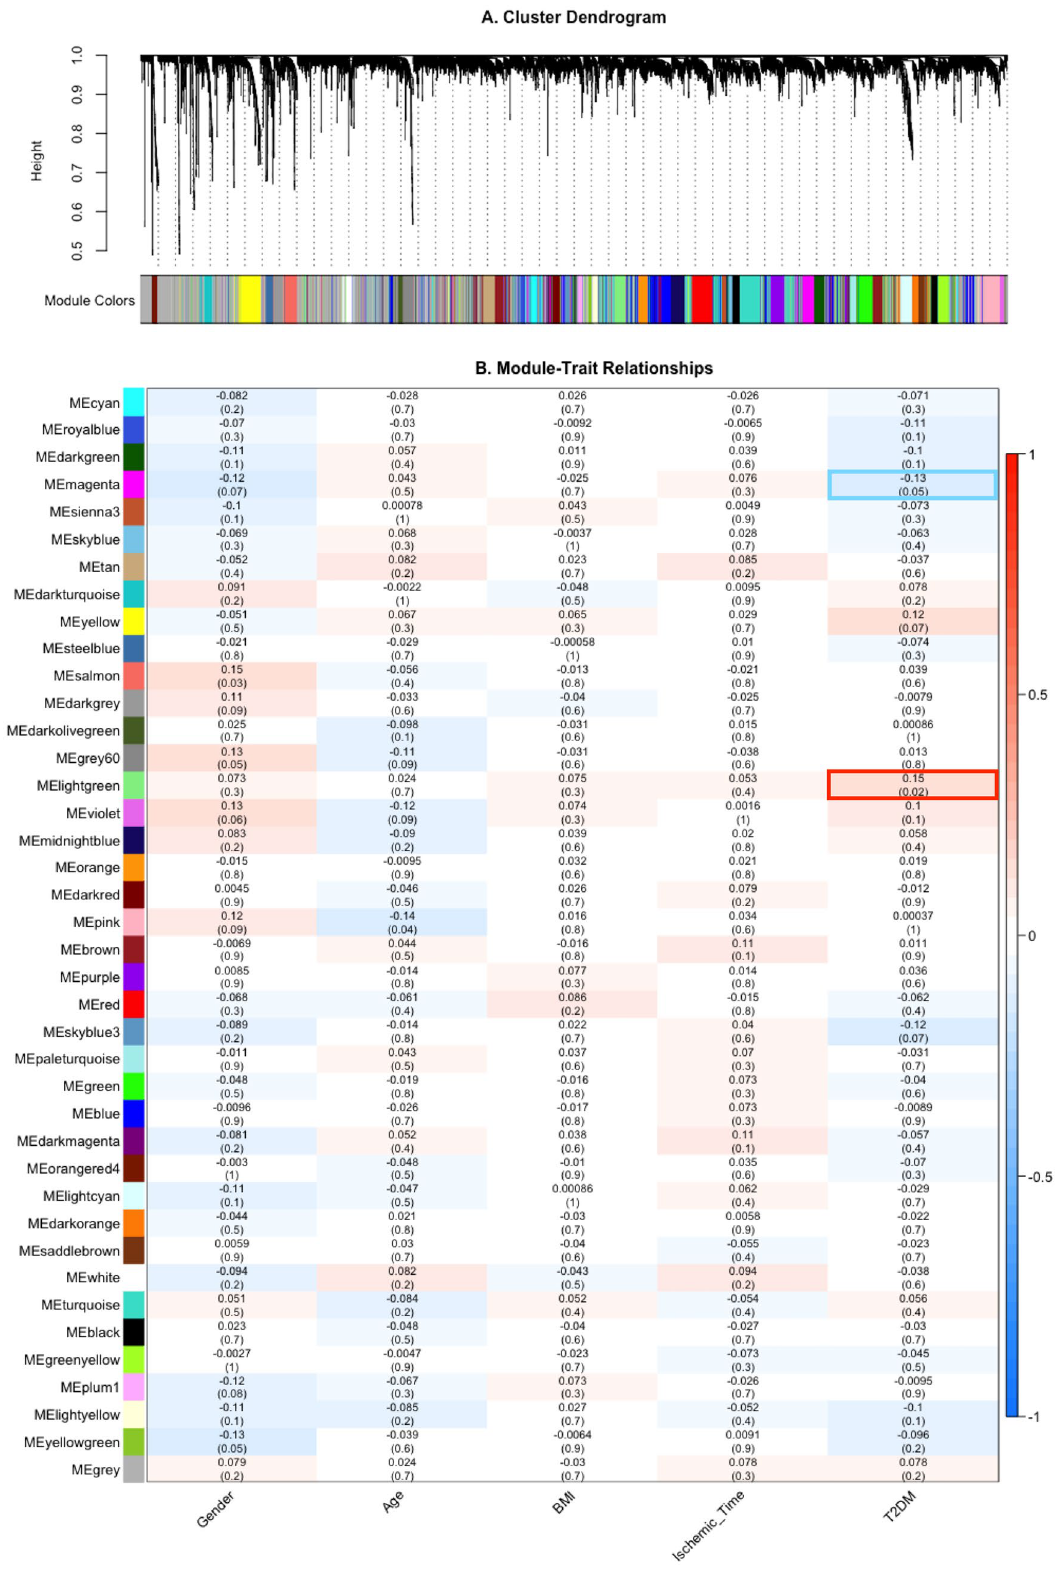
Figure 1. Gene co-expression network generation. ( A ) Cluster dendrogram denoting gene modules: based on hierarchical clustering of topological overlap dissimilarity, modules were identified and denoted with different colors. ( B ) Module-trait relationships: the heatmap represents is a correlation matrix representing the correlation and p value (in parentheses) between each ME and each